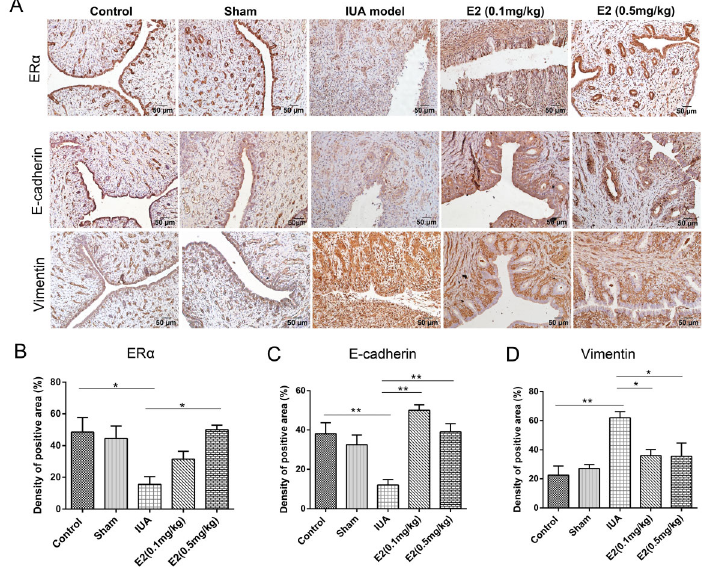
Figure 7. Impact of estrogen (E2) on epithelial-mesenchymal transition in a rabbit intrauterine adhesion (IUA) model. A , Representative images for localization of ER a , E-cadherin, and vimentin in the endometrium tissues of each group by immunohistochemical staining (magni fi cation 200 (cid:1) , scale bar 50 m m). The expression levels of ER a ( B ), E-cadherin ( C ), and vimentin ( D ) were semi-quanti fi ed by area of positive staining. Data are reported as means ± SD. *P o 0.05, **P o 0.01